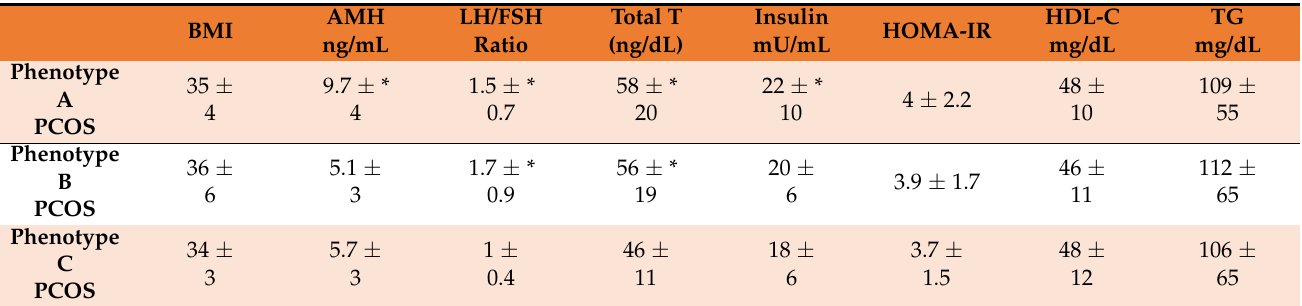
Table 3. Some hormonal and metabolic blood values in obese patients with different PCOS pheno- types.